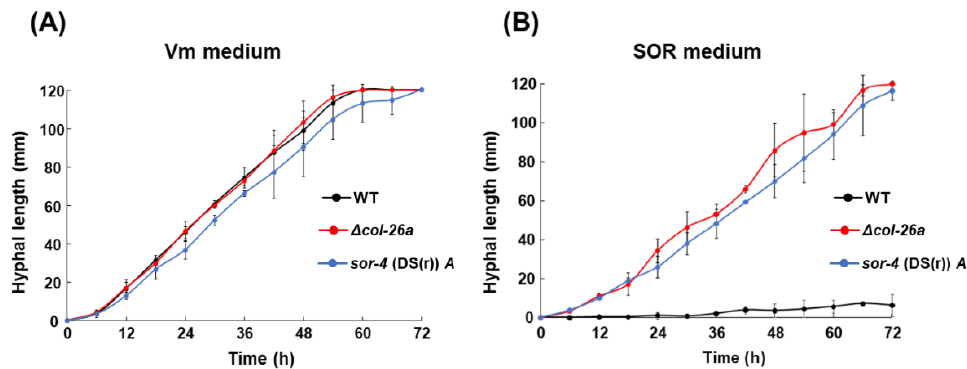
Figure 2. Comparison of growth rates of the col -26 and sor -4 mutants on Vm medium and sor medium. ( A ) Growing hyphae of the wild type, sor -4(DS(r)) A , and ∆ col -26 a strains on Vm medium were transferred onto fresh Vm medium. ( B ) Growing hyphae of the sor -4(DS(r)) A and ∆ col -26 a strains on sor medium were transferred onto fresh sor medium. For the wild-type strain, conidia were spread on the sor medium and incubated for 2 days, and then agar disks containing growing cells were transferred onto fresh sor medium. Hyphal elongation (mm) from the edges of inoculation disks were measured for 3 days. Errors are expressed as standard deviation.